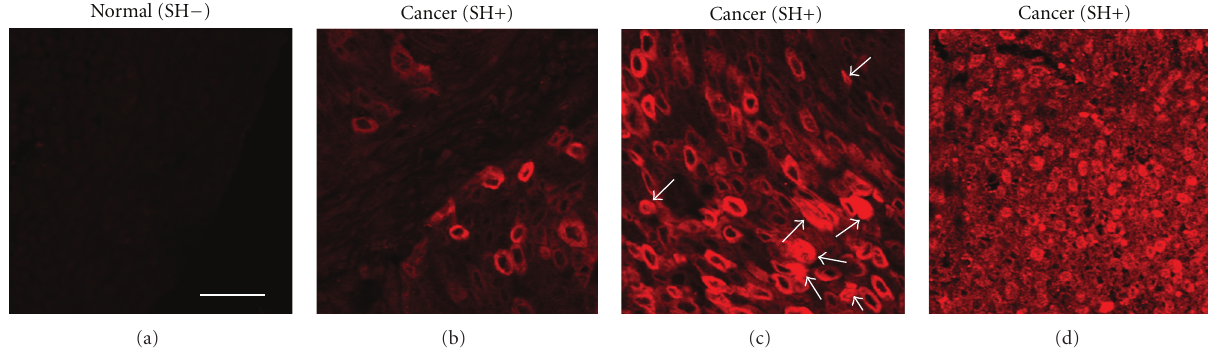
Figure 1: Localization of COX-2 in urinary bladder cancer. COX-2 (red) was stained by an immunofluorescence method in urinary bladder tissues including normal (SH − ) and cancer (SH+) tissues. (a) COX-2 was very weakly expressed in normal tissues. Scale bar is equal to 20 μ m. (b) COX-2 staining was observed only in the cytoplasm of cancer cells. (c) COX-2 was strongly expressed in both the cytoplasm and nucleus of cancer cells. Arrows indicate nuclear positive staining. (d) COX-2 was strongly expressed in the nucleus of cancer cells. SH: S. haematobium infection. Table 2: Expression of COX-2, Oct3/4 and CD44v6 in urinary bladder